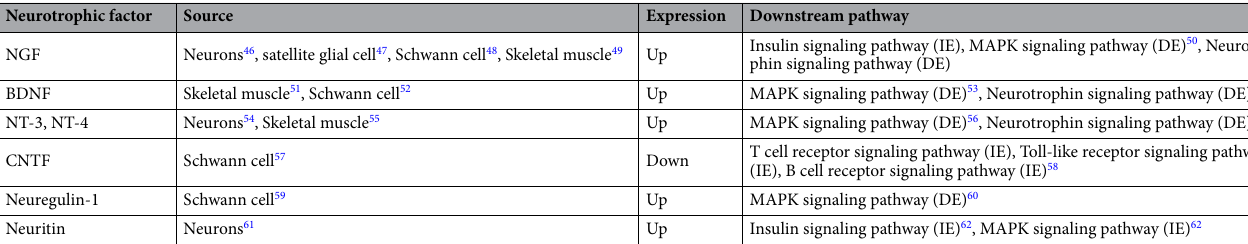
Table 8. Altered neurotrophic factor expression in injured neurons or muscle. NGF nerve growth factor, BDNF brain-derived neurotrophic factor, NT neurotrophin, DE direct evidence, IE indirect evidence.